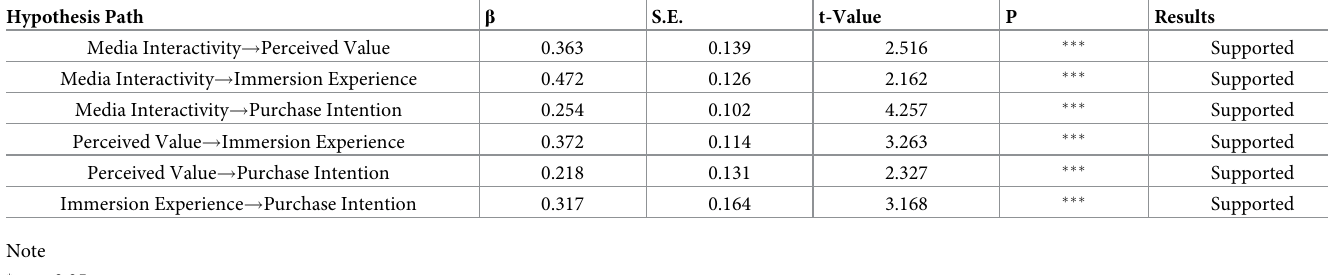
Table 5. Path coefficients of the structural